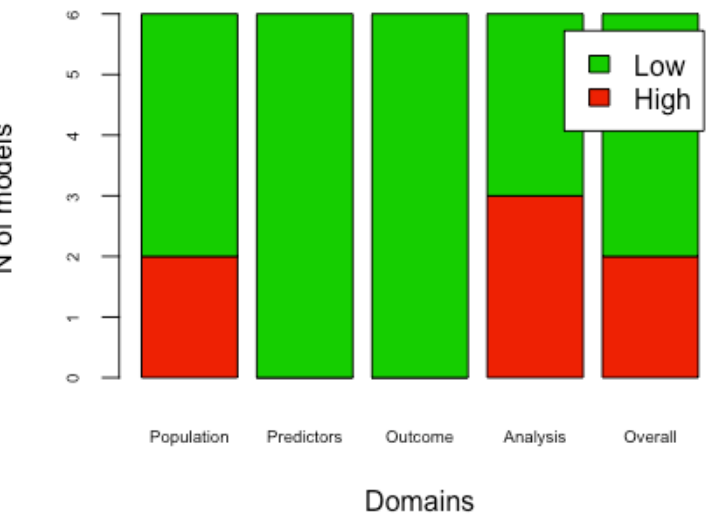
Figure 2. Risk of bias of the developed prognostic models: For each of the six prognostic models included in this systematic review, four domains of bias (population, predictors, outcomes, analysis) were evaluated as “high” or “low”. In this way, the overall risk of bias of each article was assessed.